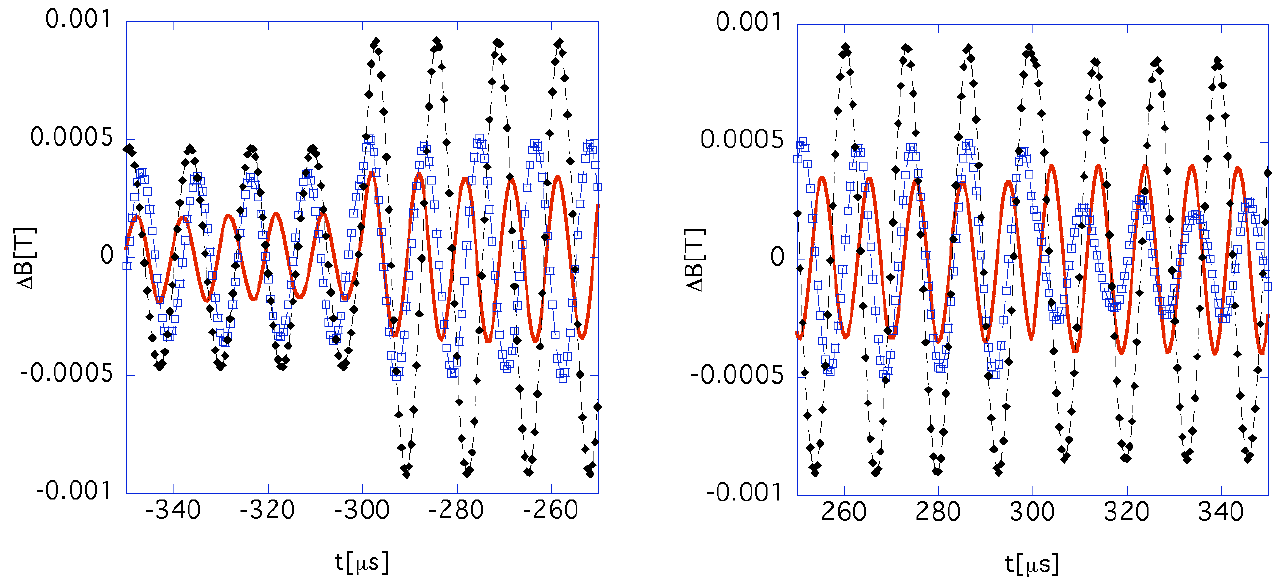
FIG. 24. (Color) The dependence on the number of working capacitors k of the field modulation (theoretical results) caused by the magnetic flux traversing the Cu coils. The original magnetic flux is excited outside the chamber, as in Fig. 13 (analytical data). The left figure gives the behavior of field modulation around t ¼ (cid:1) 300 (cid:5) s , while the right figure behavior around t ¼ 300 (cid:5) s . The red, blue, and black lines represent the cases where the number of working capacitors k is 40, 60, and 100, respectively. The attached capacitance C ¼ 0 : 3 (cid:5) F was used as a typical parameter, The other parameters are the same as in the left of Fig. 14. Namely, the chamber radius a is 15.25 cm, the radius of Cu stripe b is 2.5 mm, the total number of Cu stripes N is 100, and the conductivity of copper (cid:3) is 5 : 9 (cid:3) 10 7 = (cid:3)m . The chamber is surrounded by the magnet yoke with its longitudinal length 80 cm, and its equal gap height 2 g ¼ 32 : 0 cm and gap width 2 h ¼ 32 : 0 cm